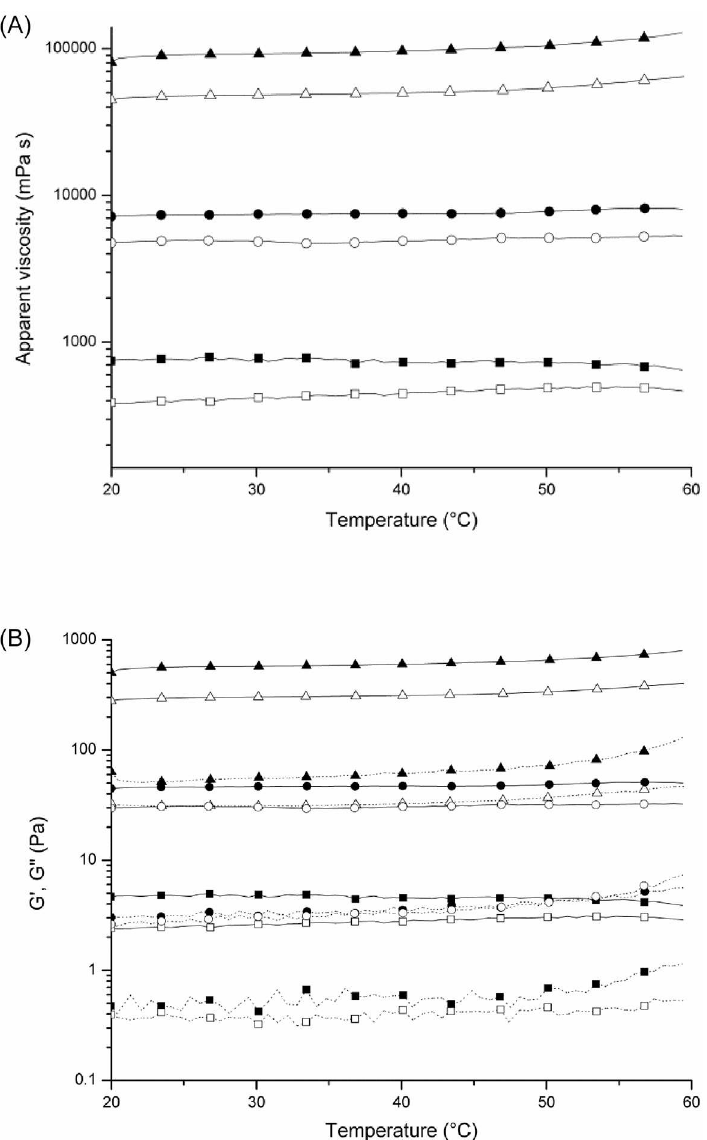
Fig 3. Temperature dependency of: (A) apparent viscosity and (B) G’ (continuous line) and G" (dotted line) modulus of the aqueous dispersions of curdlan. Pre-gelledcommercial curdlan (empty symbol) and curdlan produced by Agrobacterium sp. IFO 13140 recoveredby the pre-gelation method (full symbol) at ( ■ ) 20, ( ● ) 40 and ( ▲ ) 80 g L -1